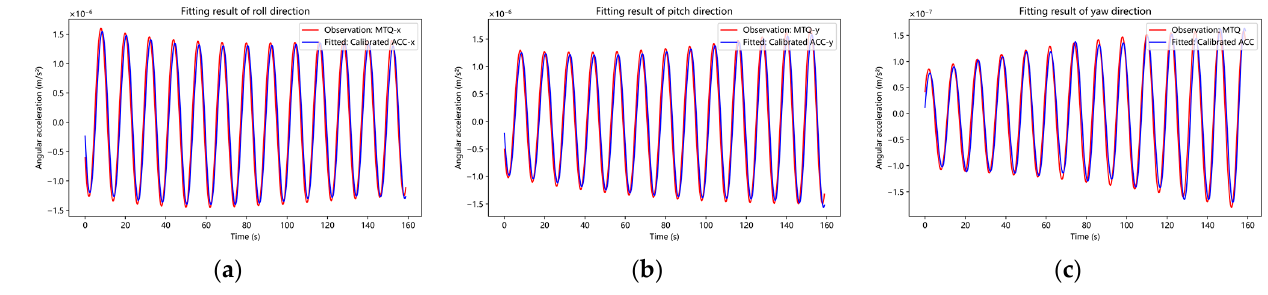
Figure 9. Calibration of angular acceleration measurements of ACC: ( a ) roll; ( b ) pitch; ( c ) yaw.